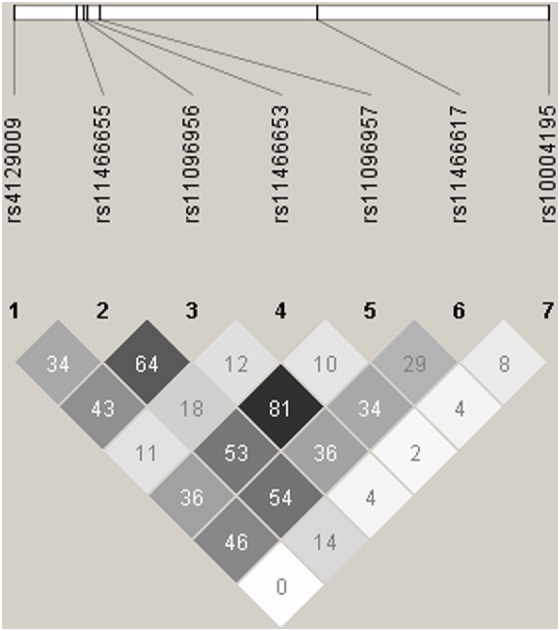
Linkage disequilibrium (LD) plots for LTR10. The LD plots were generated by Haploview 4.2. Polymorphisms are identified by their dbSNP rs numbers, and their relative positions are marked by vertical lines within the white horizontal bar. The numbers within squares indicate the r2 value, expressed as a percentile.